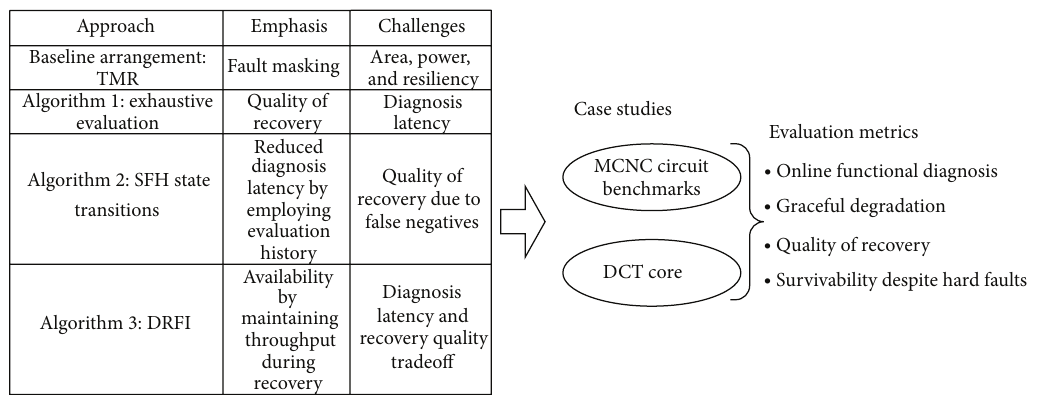
Figure 3: Online fault diagnosis strategies evaluated herein to availability, throughput degradation, and latency tradeoffs.